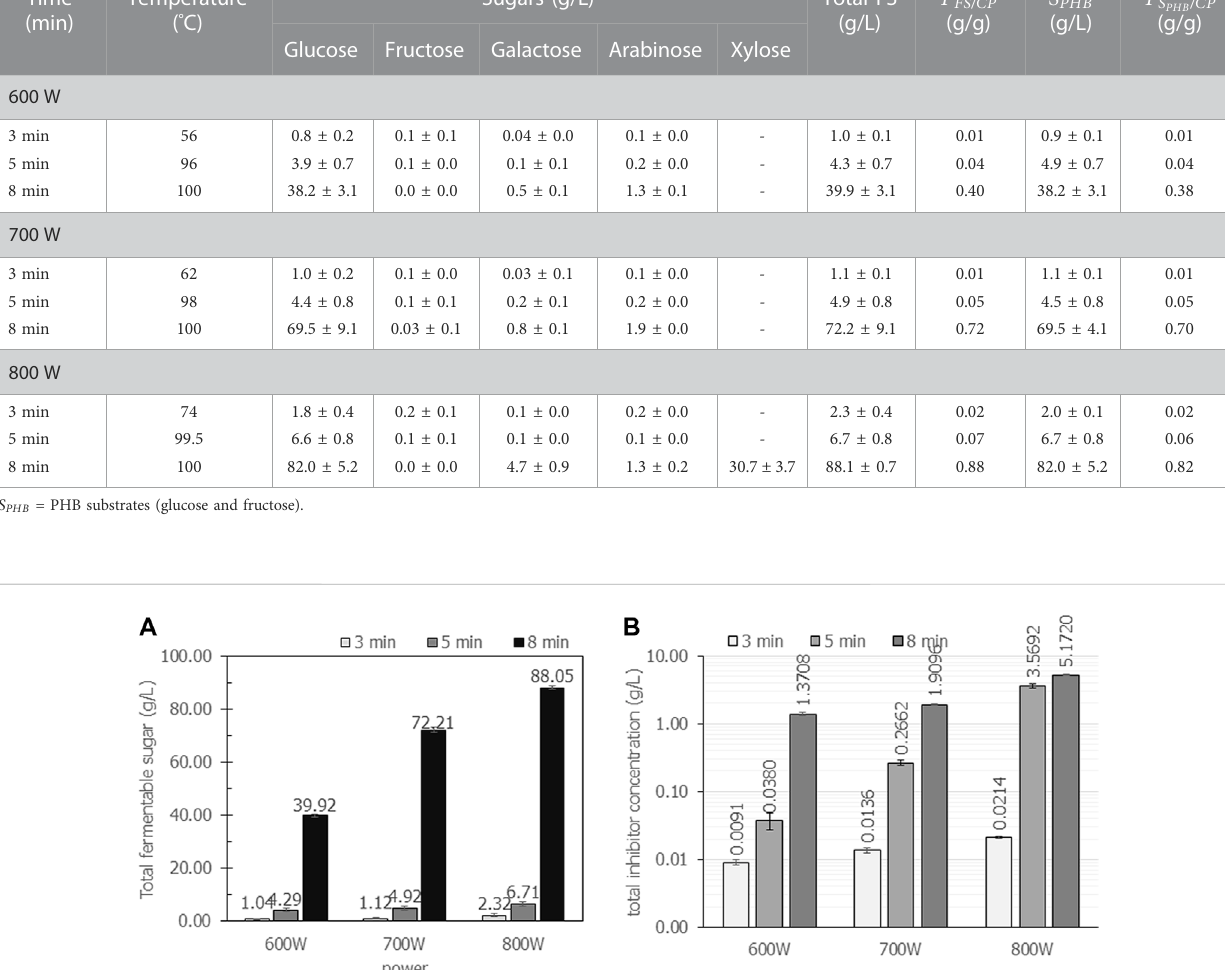
TABLE 2 Effect of wattage power and time on sugar yield and reactant temperature. Five grams of samples were hydrolyzed with 2.5% (v/v) H 2 SO 4 and wattage power was varied at 600 W, 700 W, and 800 W for 3, 5 and 8 min. Time (min)